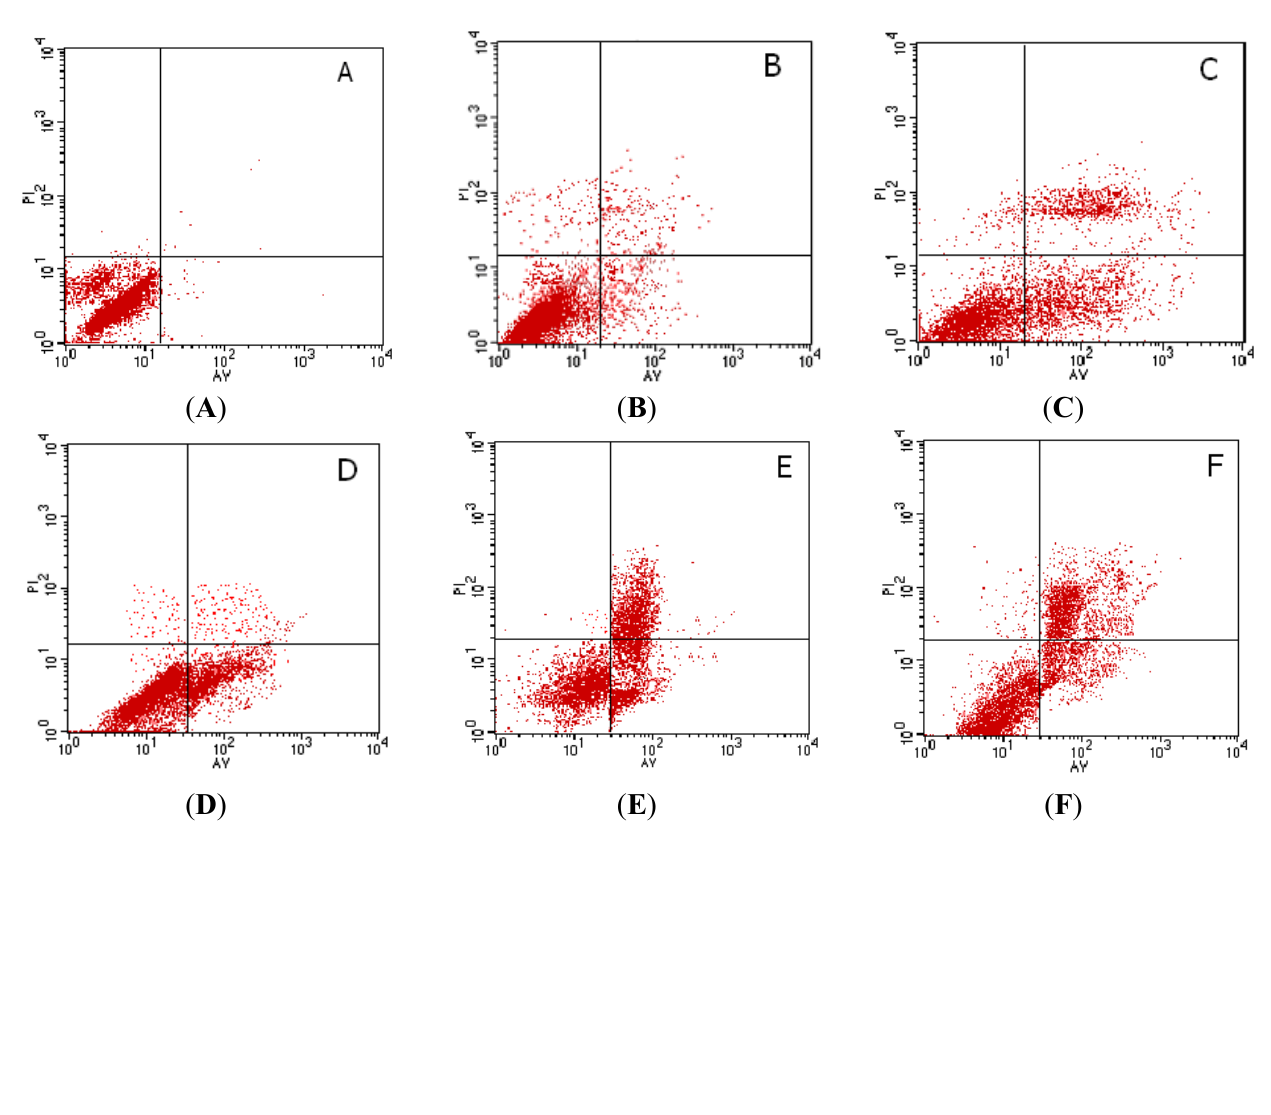
Figure 3. Flow cytometry analysis for PC-2 cells after treatment by Annexin V-FITC and PI staining for apoptosis. ( A ) 0 nmol/L Rapa group; ( B ) 10 nmol/L Rapa